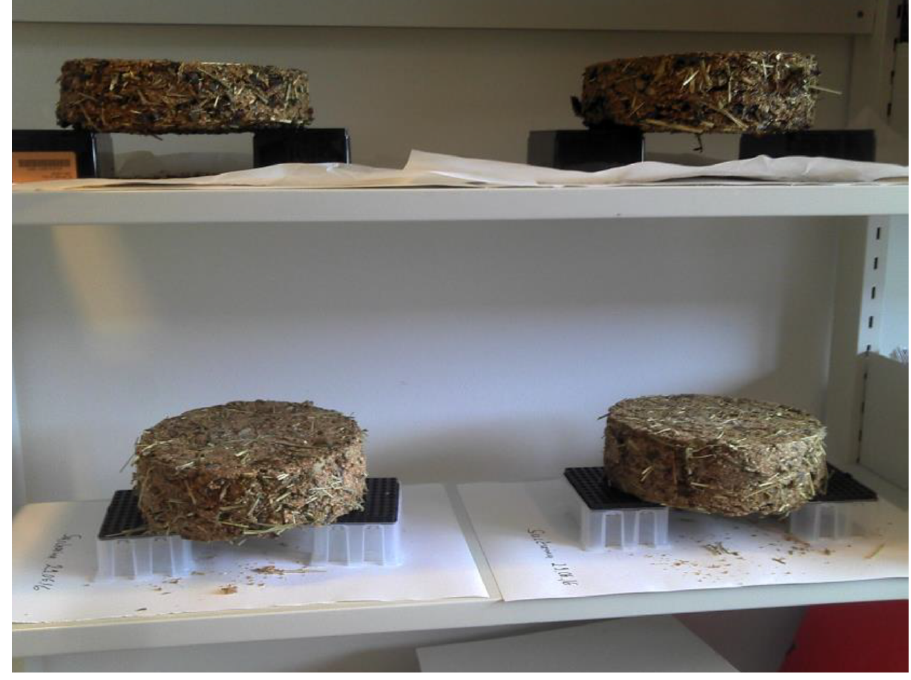
Figure 1. Multinutrient blocks (MB) stored at room temperature (20 °C).